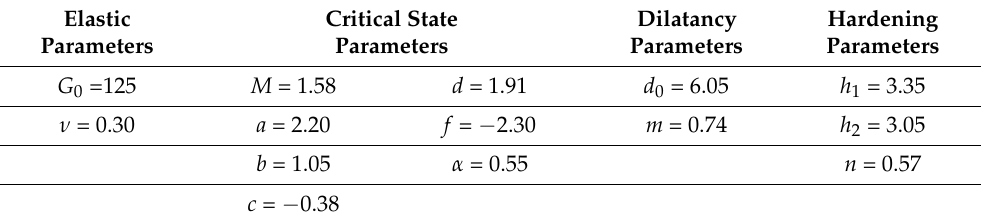
Dilatancy Parameters